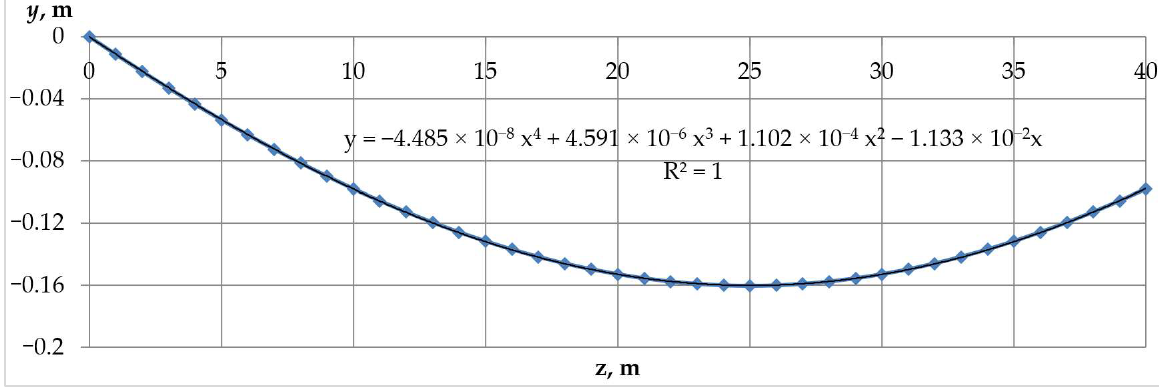
Figure 19. The graph of the modeled pipeline deflection. The initial data for the calculation are presented in Table 3. Table 3. Initial data for calculation. Parameter